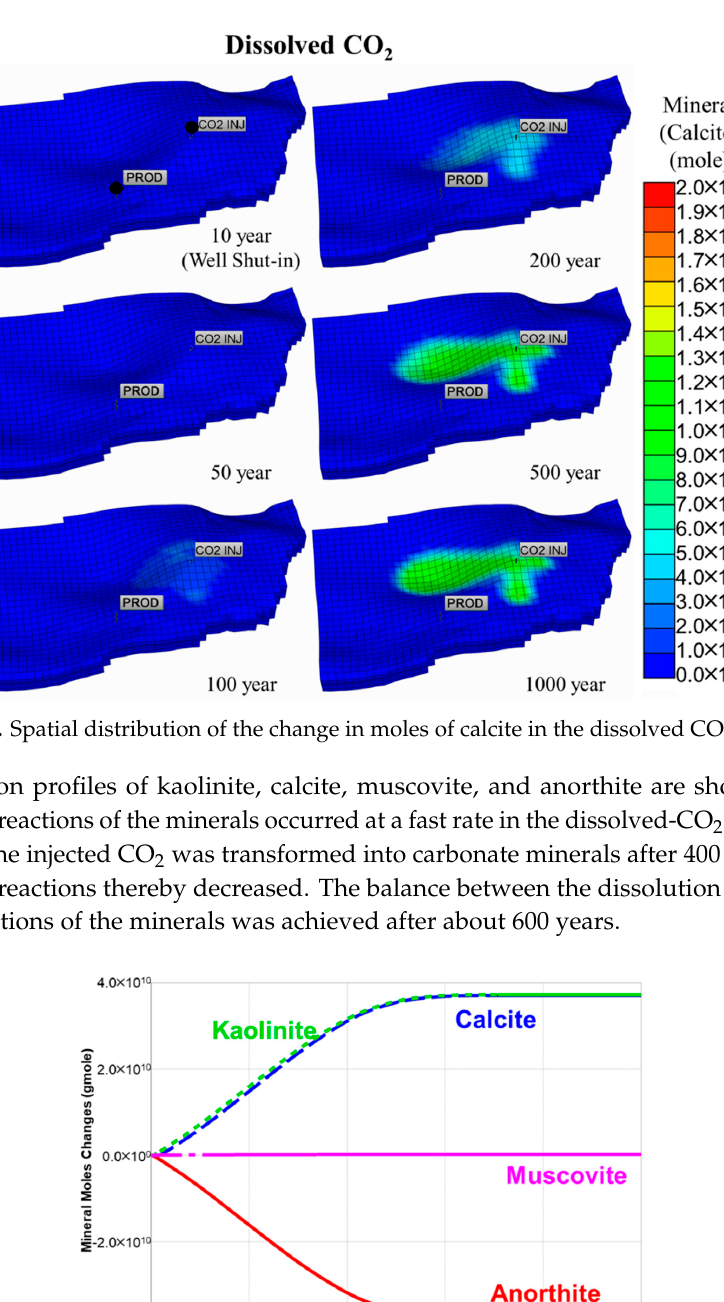
Figure 13. Evolutions of kaolinite, calcite, muscovite, and anorthite in the dissolved CO 2